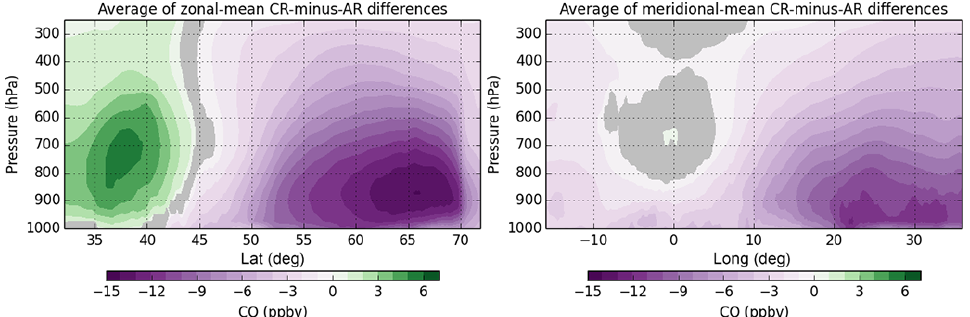
Figure 9. Zonal (left panel) and meridional (right panel) slices of the difference between the CR and AR CO fields, units of ppbv, averaged over the summer period (1 June–31 August 2003). The areas highlighted in grey color indicate where the AR is not significantly different to the CR at the 99% confidence level. The labels in the left panel are latitude in degrees ( x axis) and pressure in hPa ( y axis). The labels in the right panel are longitude in degrees ( x axis) and pressure in hPa ( y axis). Green/purple colors indicate positive/negative values in the difference